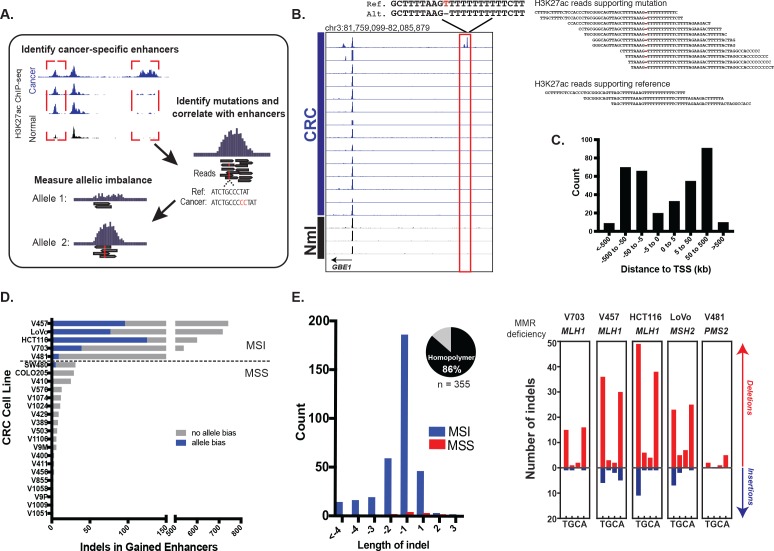
Identification of functional enhancer mutations from H3K27ac ChIP-seq data.(A) Overview of approach. (B) (left) Genome Browser snapshot of a putative enhancer-activating indel detected at a CRC-specific H3K27ac peak. Y-axis scales are all 0 to 25. (right) H3K27ac ChIP-seq reads covering indel locus. (C) Distribution of CRC-specific H3K27ac peaks containing indels relative to transcription start sites. (D) Number of gained enhancer-associated indels with and without allele bias detected in each CRC cell line. Enhancer mutations are provided in Figure 1—source data 1. (E) (left) Distribution of indel lengths detected in gained enhancers in MSI and MSS CRC samples. Pie chart shows the fraction of indels detected in homopolymers. (right) Number of insertion (blue) and deletion (red) mutations in homopolymers of T, G, C, or A in MSI cell lines.10.7554/eLife.40760.005Figure 1—source data 1.Enhancer indel mutations detected from H3K27ac ChIP-seq data in cell lines and primary tumors.